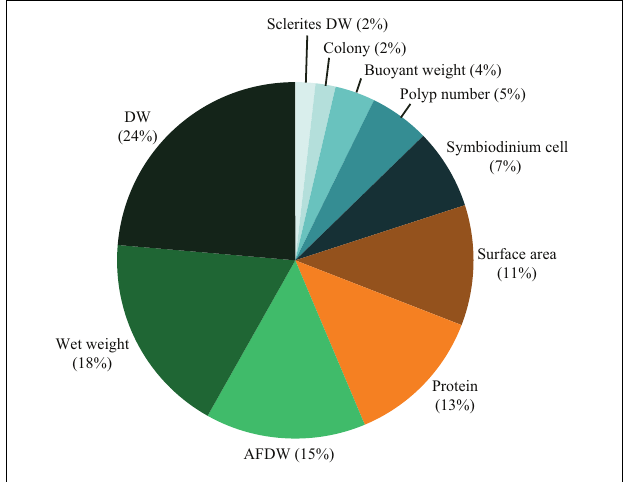
FIGURE 1 | Normalization metrics used in physiological studies on soft corals. Percentages are based on the occurrence of the studies using the metric of interest. DW, dry weight; AFDW, ash-free dry